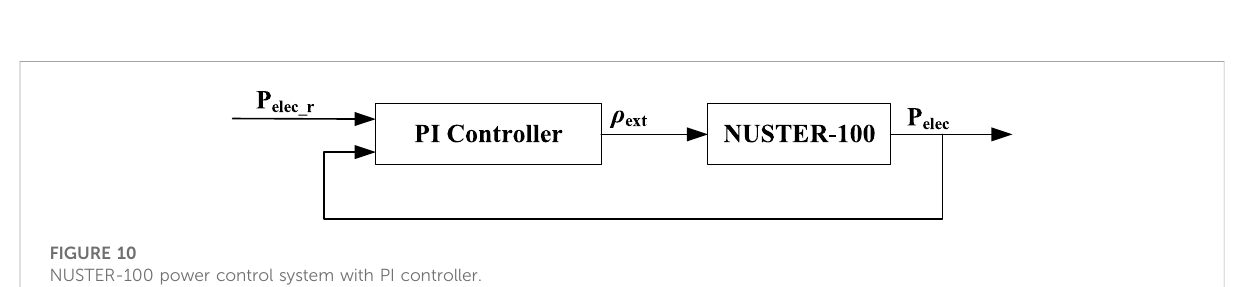
NUSTER-100 power control system with PI